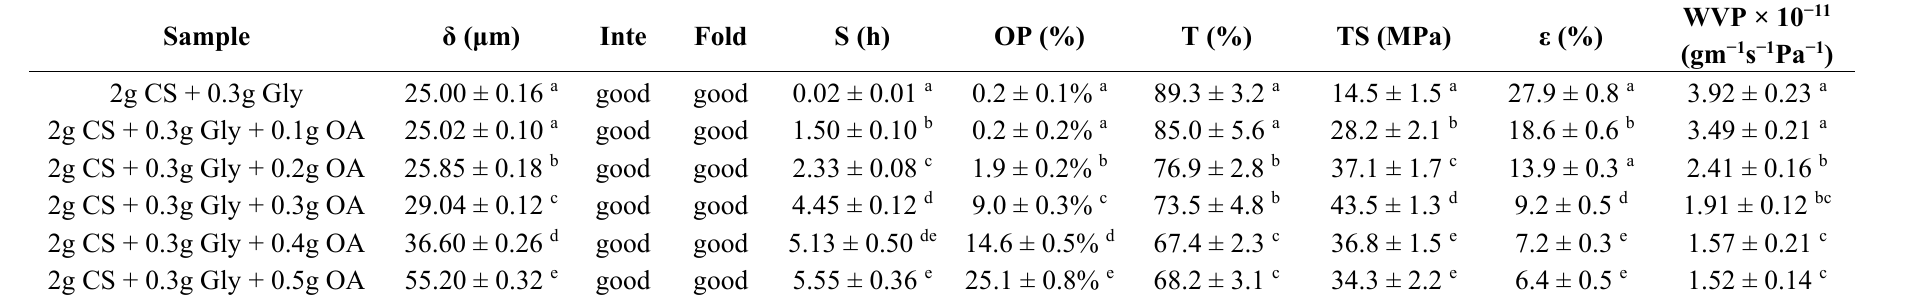
Table 1. The effects of OA content on properties of oleic acid-cellulose sulfate